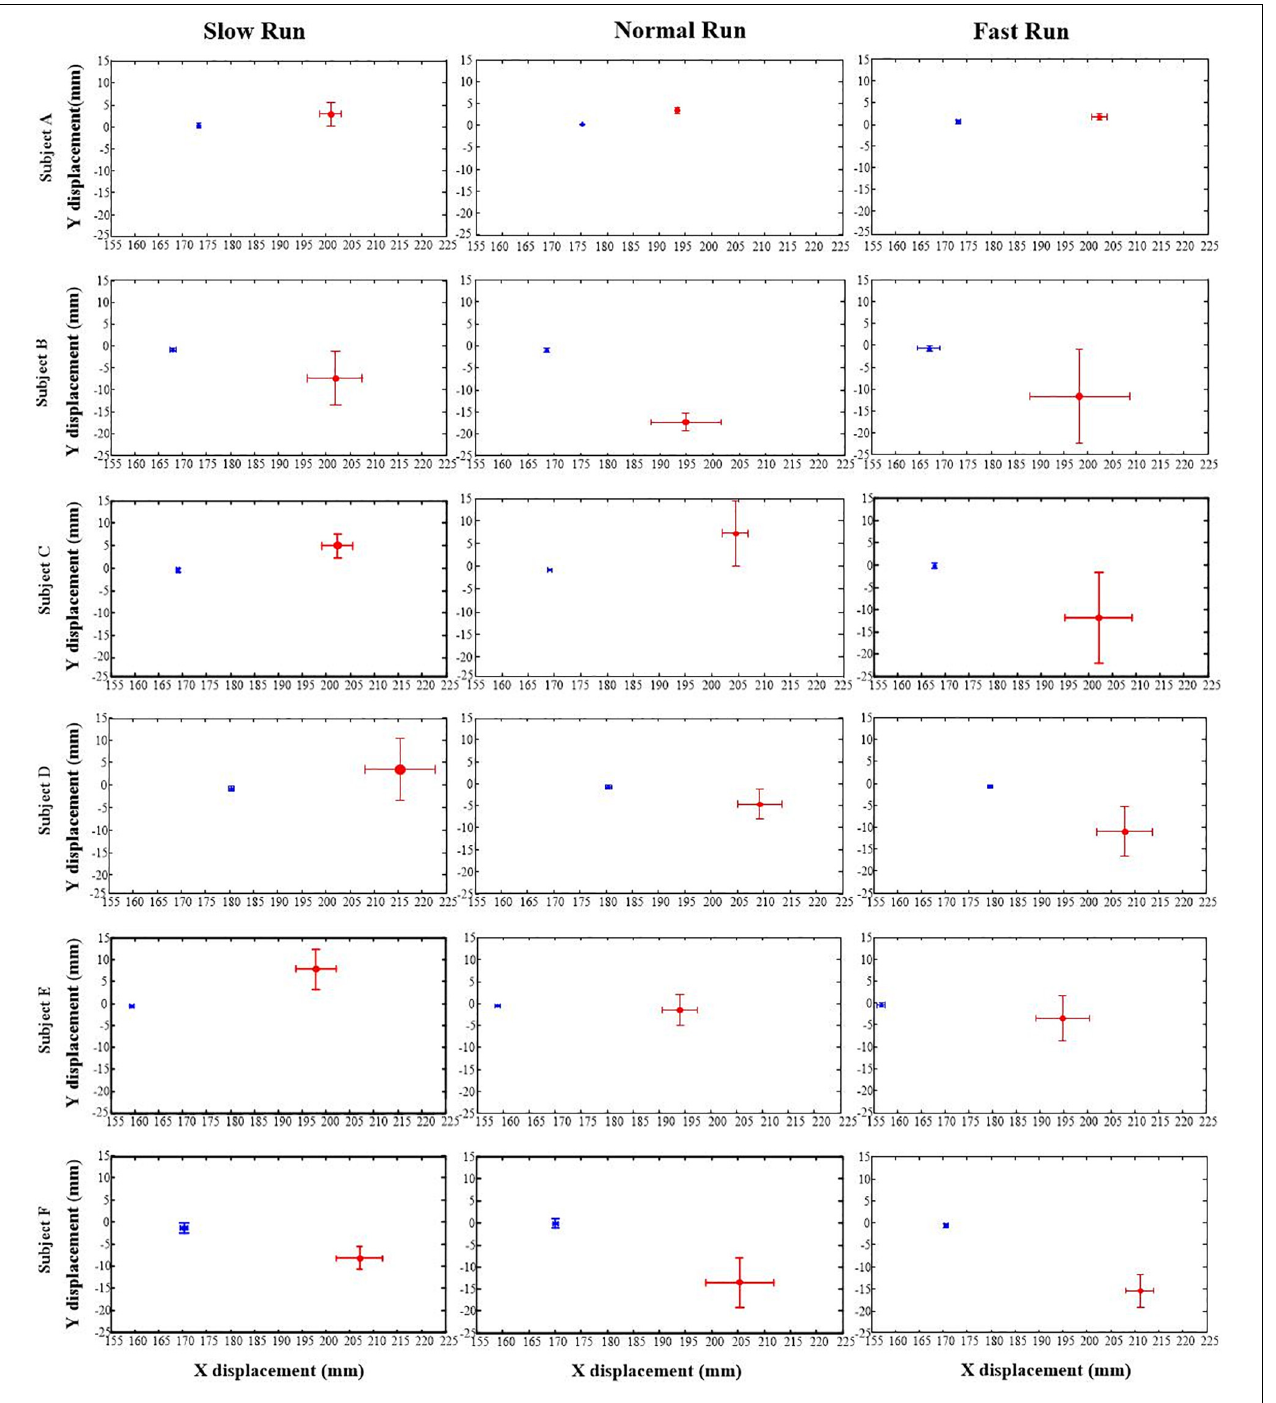
FIGURE 2 | The positions of the anatomical axis (blue) and the functional axis (red) of the MP joint for all the six subjects (A–F) across all the three speeds of running (slow, normal, fast). Solid dots depict mean; bars depict the 1 SD zones.